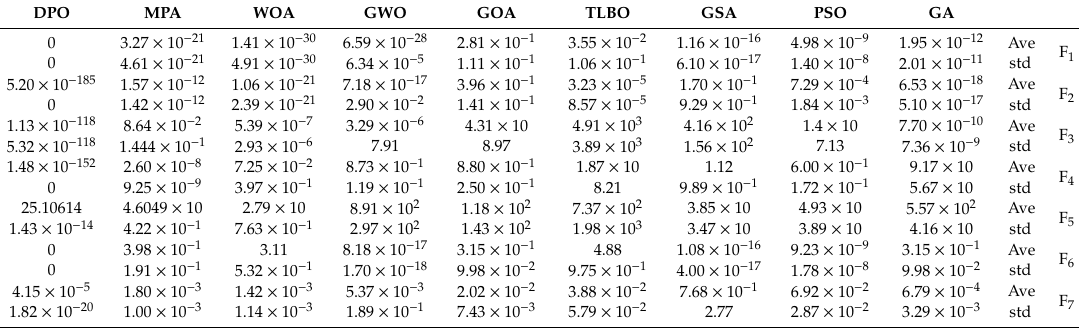
Table 1. Optimization results on unimodal test functions.